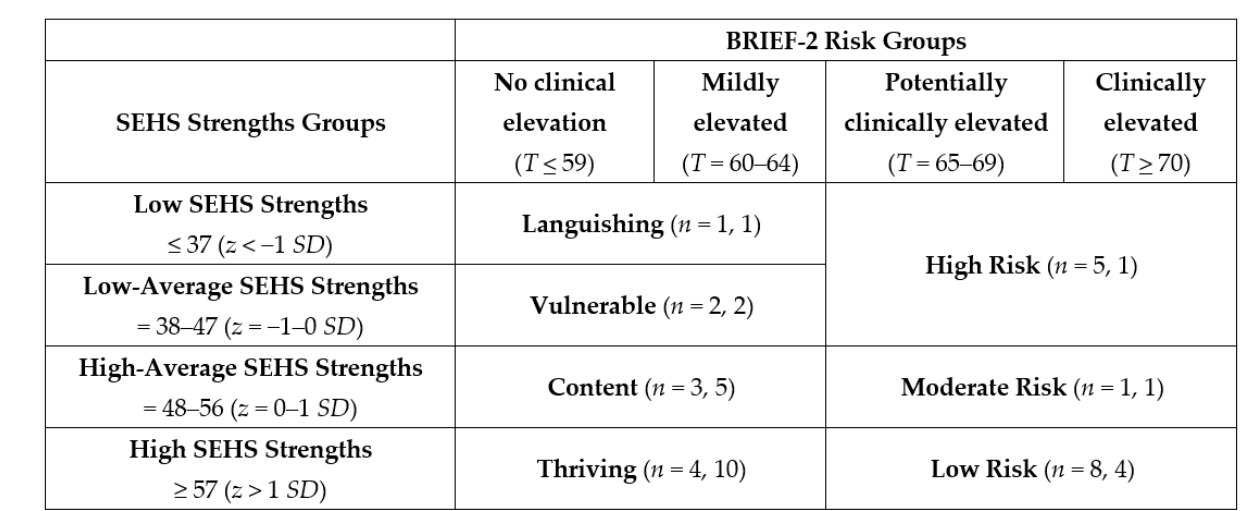
Figure 2. Universal Screening Matrix for School-Based Wellbeing. N = 24; n = number of students in each risk by strength grouping across 1st- and 2nd-grade classrooms (pretest, posttest). BRIEF-2 = Behavior Rating Inventory of Executive Function ® , Second Edition [63]; SEHS = Social-Emotional Health Survey [19].